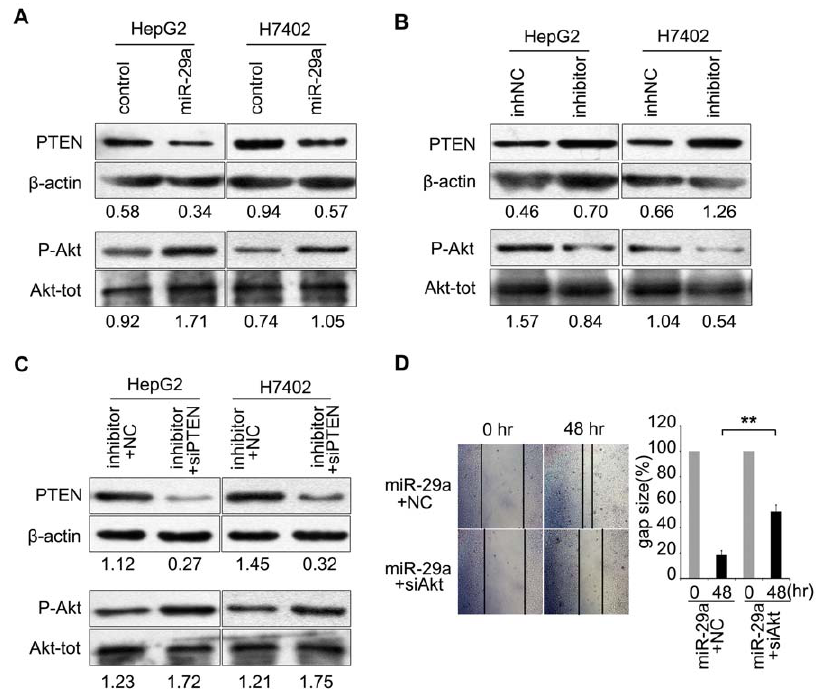
Figure 5. Akt phosphorylation is regulated by miR-29a through PTEN. (A, B) The phosphorylation level of Akt (P-Akt) and the expression level of total Akt (Akt-tot) were detected by Western blot analysis in HepG2 and H7402 cell lines after transfection of miR-29a (or a specific inhibitor). (C) Western blot analysis showed the phosphorylation of Akt (P-Akt) and the expression of total Akt (Akt-tot) in the cells treated by PTEN siRNA when the hepatoma cells were transfected with miR-29a inhibitor. Protein bands were quantified using Quantity One software (Bio-Rad). The value under each lane indicates the relative expression level of PTEN or phosphorylated Akt, which is represented by the intensity ratio between PTEN or phosphorylated Akt and b -actin or total Akt bands in each lane. (D) A wound healing assay showed that enhanced cell migration by miR-29a was abolished by Akt siRNA. One representative experiment is shown. Black arrows indicate the wound edge.